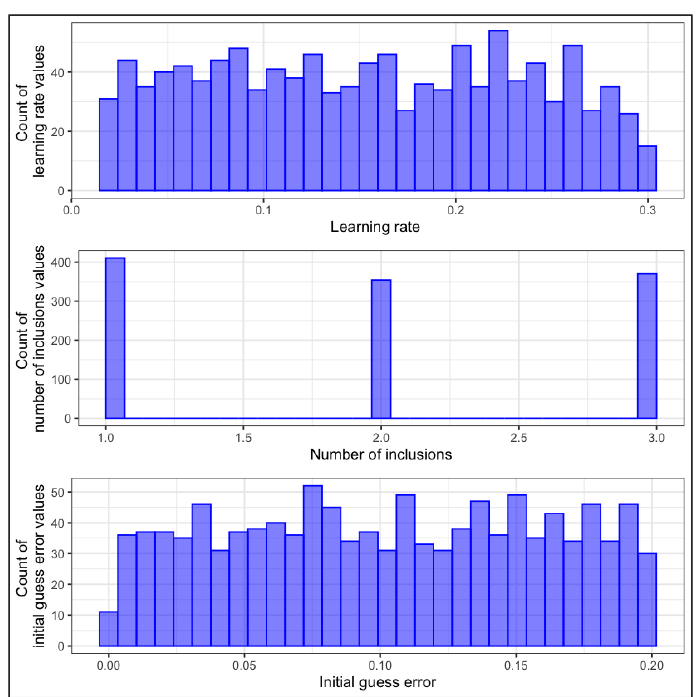
Figure 1. Distribution of the learning rate hyper parameter β on the top, number of inclusions n in the middle, and the initial guess error δ on the